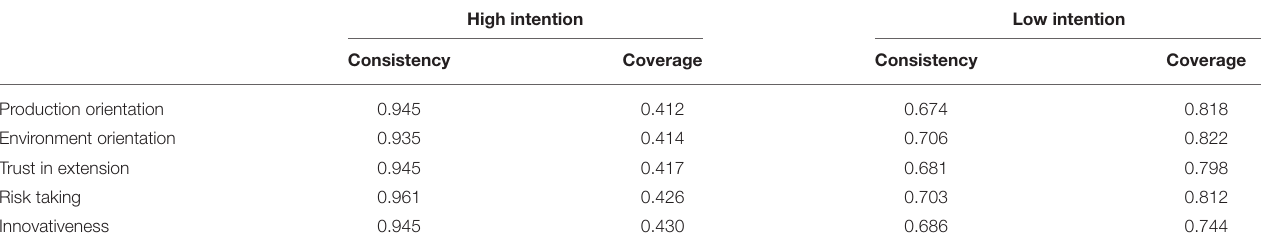
TABLE 4 | Analysis of necessary conditions for higher intention to use CAPs.